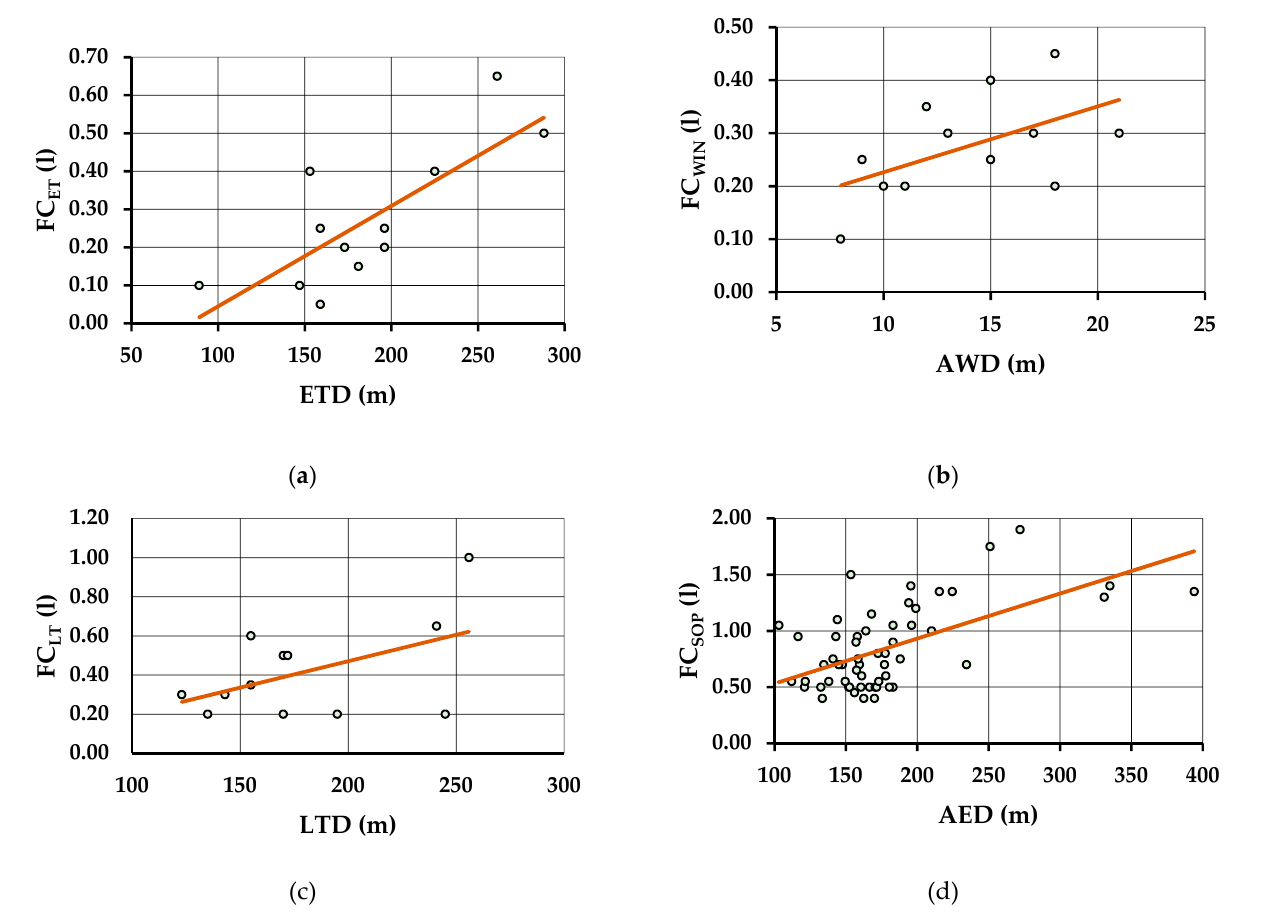
Figure 5. Fuel consumption estimates: ( a ) variation in fuel consumption for empty turn (FC ET ) as a function of empty turn distance (ETD); ( b ) variation in fuel consumption for winching and payload attachment (FC WIN ) as a function of average winching distance (AWD); ( c ) variation in fuel consumption for loaded turn and payload detachment (FC LT ) as a function of loaded turn distance (LTD); ( d ) variation in fuel consumption for skidding operations (FC SOP ) as a function of average extraction distance (AED). Table 9. Predictive models of fuel consumption for skidding operations.